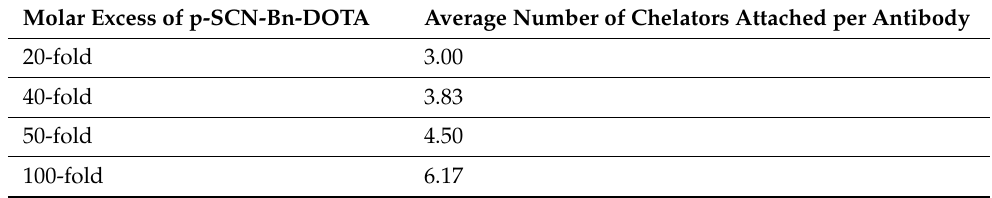
Table 2. Effect of changing molar-excess on the average number of DOTA chelators per antibody. Molar Excess of